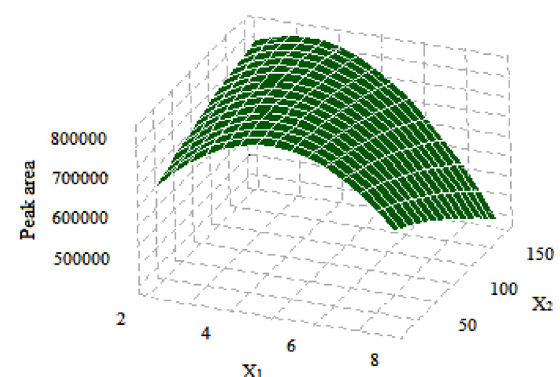
Figure 3. The response surface plots for the peak area as a function of the pH of the sample solution and volume of extraction